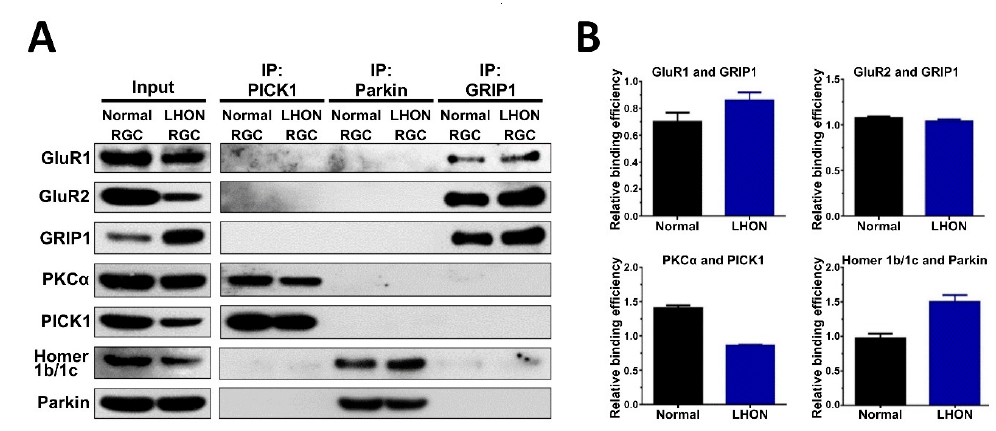
Figure 5. Protein–protein interactions between AMPA receptors and their associated scaffold proteins in LHON-RGCs. ( A ) Western blot analysis of PICK1, Parkin and GRIP1 immunoprecipitates from lysates of 21-day Normal-RGCs and LHON-RGCs (right panel). The aliquots of total lysates were analyzed in parallel (left panel). ( B ) Quantification of signal intensity in the indicated immunoprecipitates using ImageJ. The signal of protein binding was normalized to the signal of immunoprecipitated protein. * p < 0.05, ** p < 0.01 and *** p < 0.001.